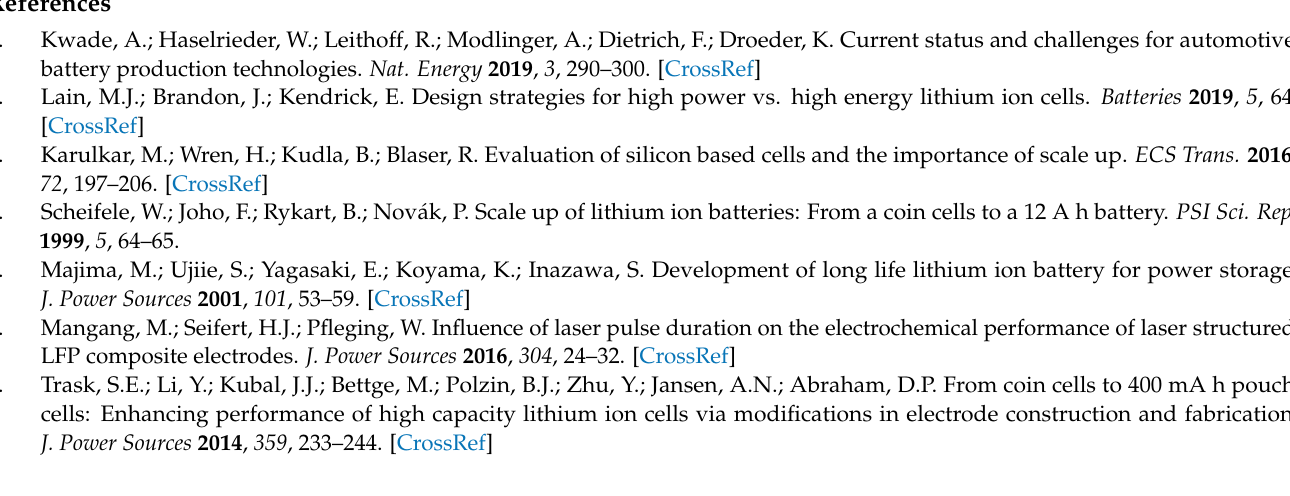
Table S2. Cell Allocation for Tests after Formation Table S3. Initial Voltage Drops during Pulses At 50 % State of Charge Figure S1. Further formation cycle results with (A) cell voltages during formation cycle, (B) first cycle loss values, (C) areal discharge energies from formation cycle and (D) areal excess of anode capacity. Figure S2. Coulombic efficiency measurements during cycling at (A) ± C/2 and (B) ± 3 C. Figure S3. Average voltage calculations for cycling at ± C/2, for (A) charge, (B) discharge, (C) shift voltage, and (D) resistance voltage. Figure S4. DC resistance measurements using 5 C pulses during cycling at ± 3 C, with (A) all cells before cycling, (B) all cells after 1000 cycles, (C) a coin cell, and (D) a single sided pouch pair. Figure S5. Cell voltages during ASI measurements for (A) a higher resistance coin cell, (B) other full cells, (C) anode coin cell half cells, and (D) cathode coin cell half cells. Figure S6. Calculated ASI values for (A) full cells during charge pulses, (B) full cells during discharge pulses, (C) anode coin cell half cells, and (D) cathode coin cell half cells. Figure S7. Voltage transients during ten second pulses at 50 % state of charge, for (A) single sided pouch pair cells, (B) coin cell full cells, (C) anode coin cell half cells, and (D) cathode coin cell half cells. Figure S8. Discharge (or delithiation) voltages at different rates for (A) a single sided pouch pair cell, (B) a stacked pouch cell, (C) an anode coin cell half cell, and (D) a cathode coin cell half cell. Figure S9. Cell voltages during pulses for (A+B) single sided pouch pair cell, (C+D) stacked pouch cell, (A+C) two second pulse duration, and (B+D) ten second pulse duration. Figure S10. Cell voltages during GITT discharge pulses for (A) a coin cell, (B) a single sided pouch pair, (C) a stacked pouch cell, and (D) all cells at low states of